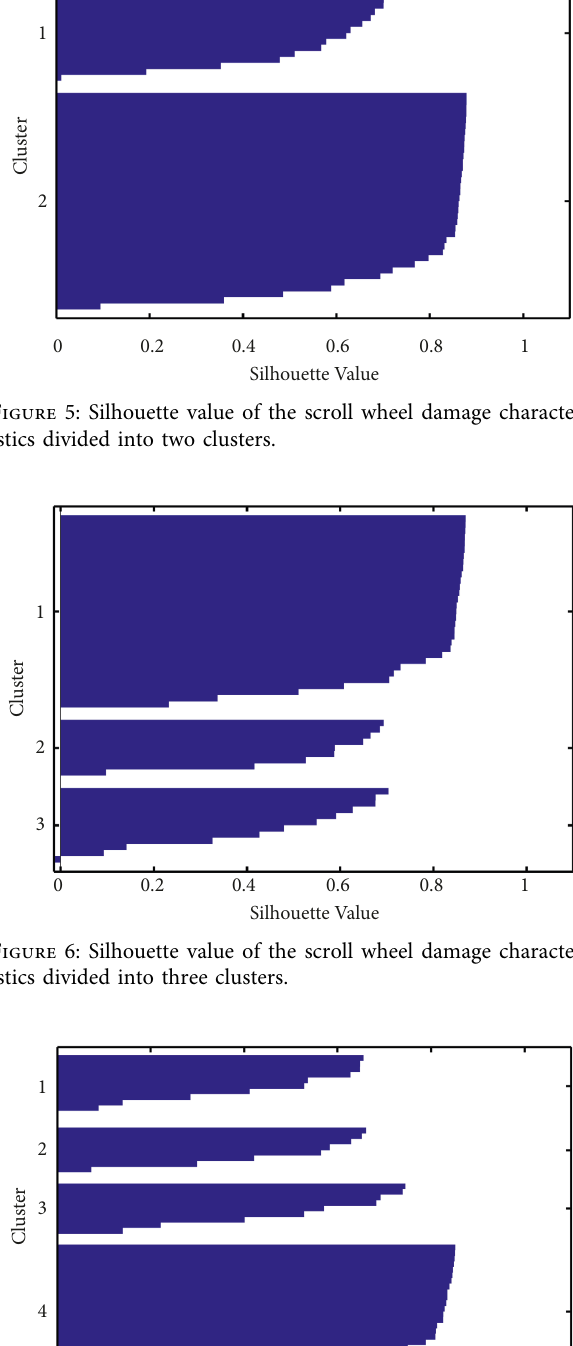
Table 1: The normalized damage characteristics of the scroll wheel.